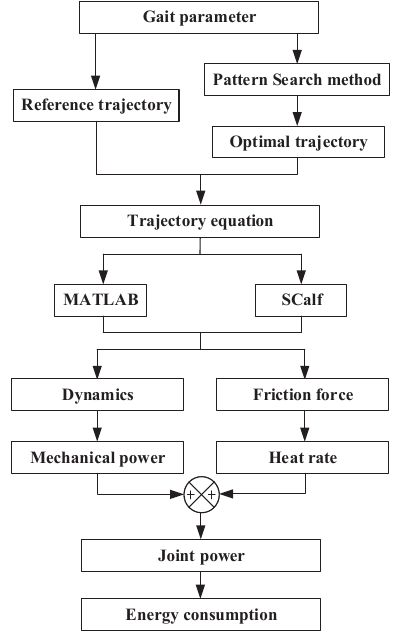
Figure 7. Routine of the energy optimal trajectory generation